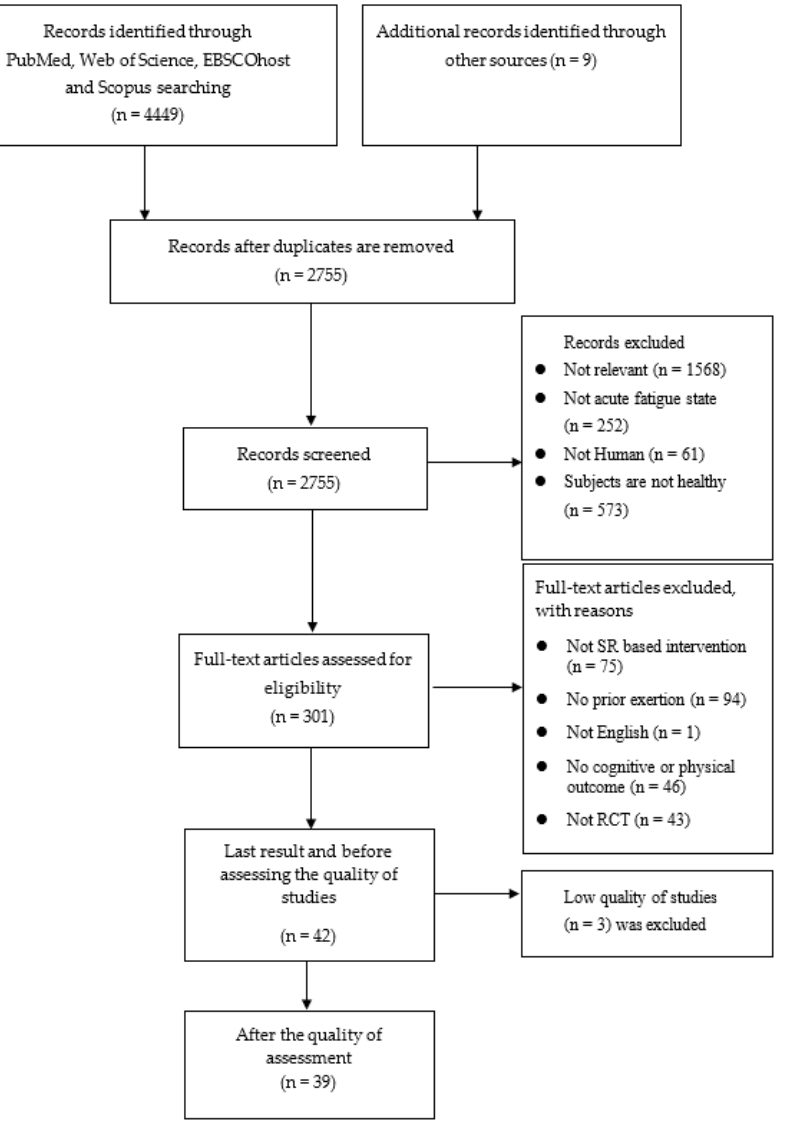
Figure 1. PRISMA of the literature selection.